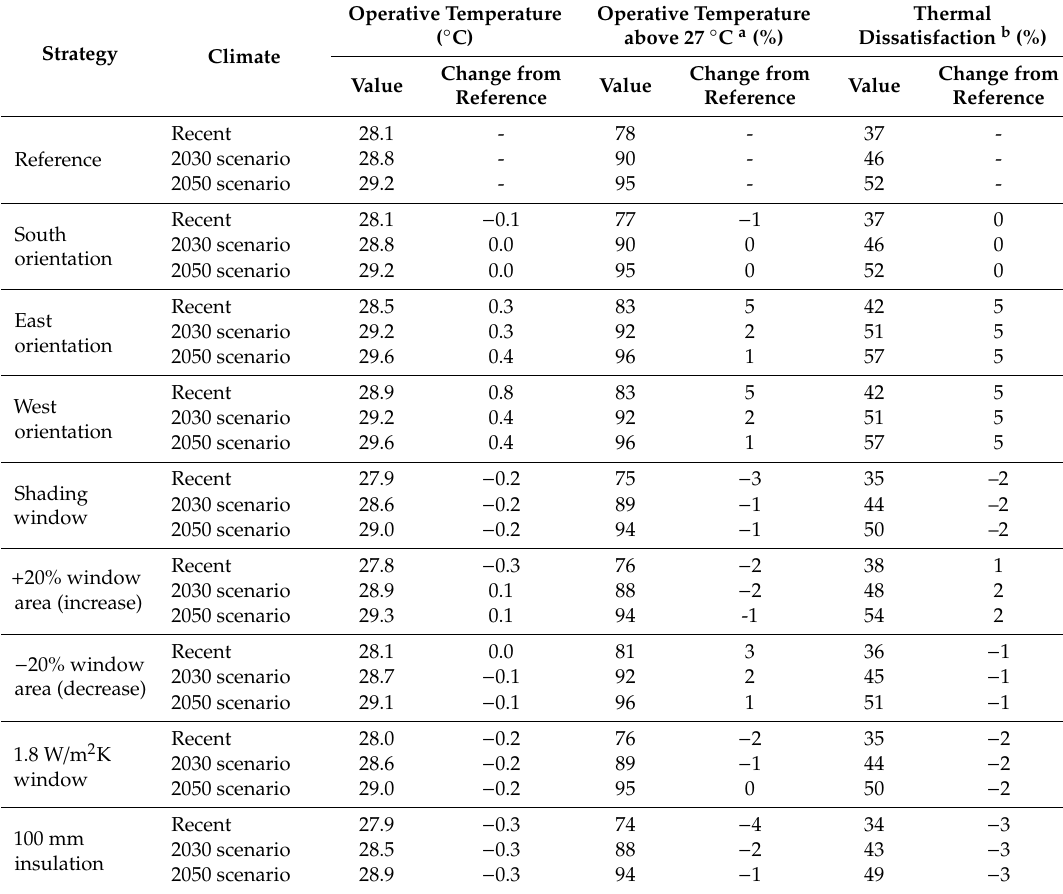
Table 8. Impacts of various strategies on the indoor comfort and environmental conditions of the building under di ff erent climate